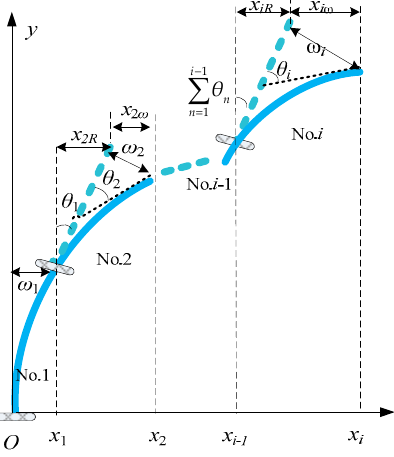
Figure 2. The schematic diagram of the beam element decomposition method.